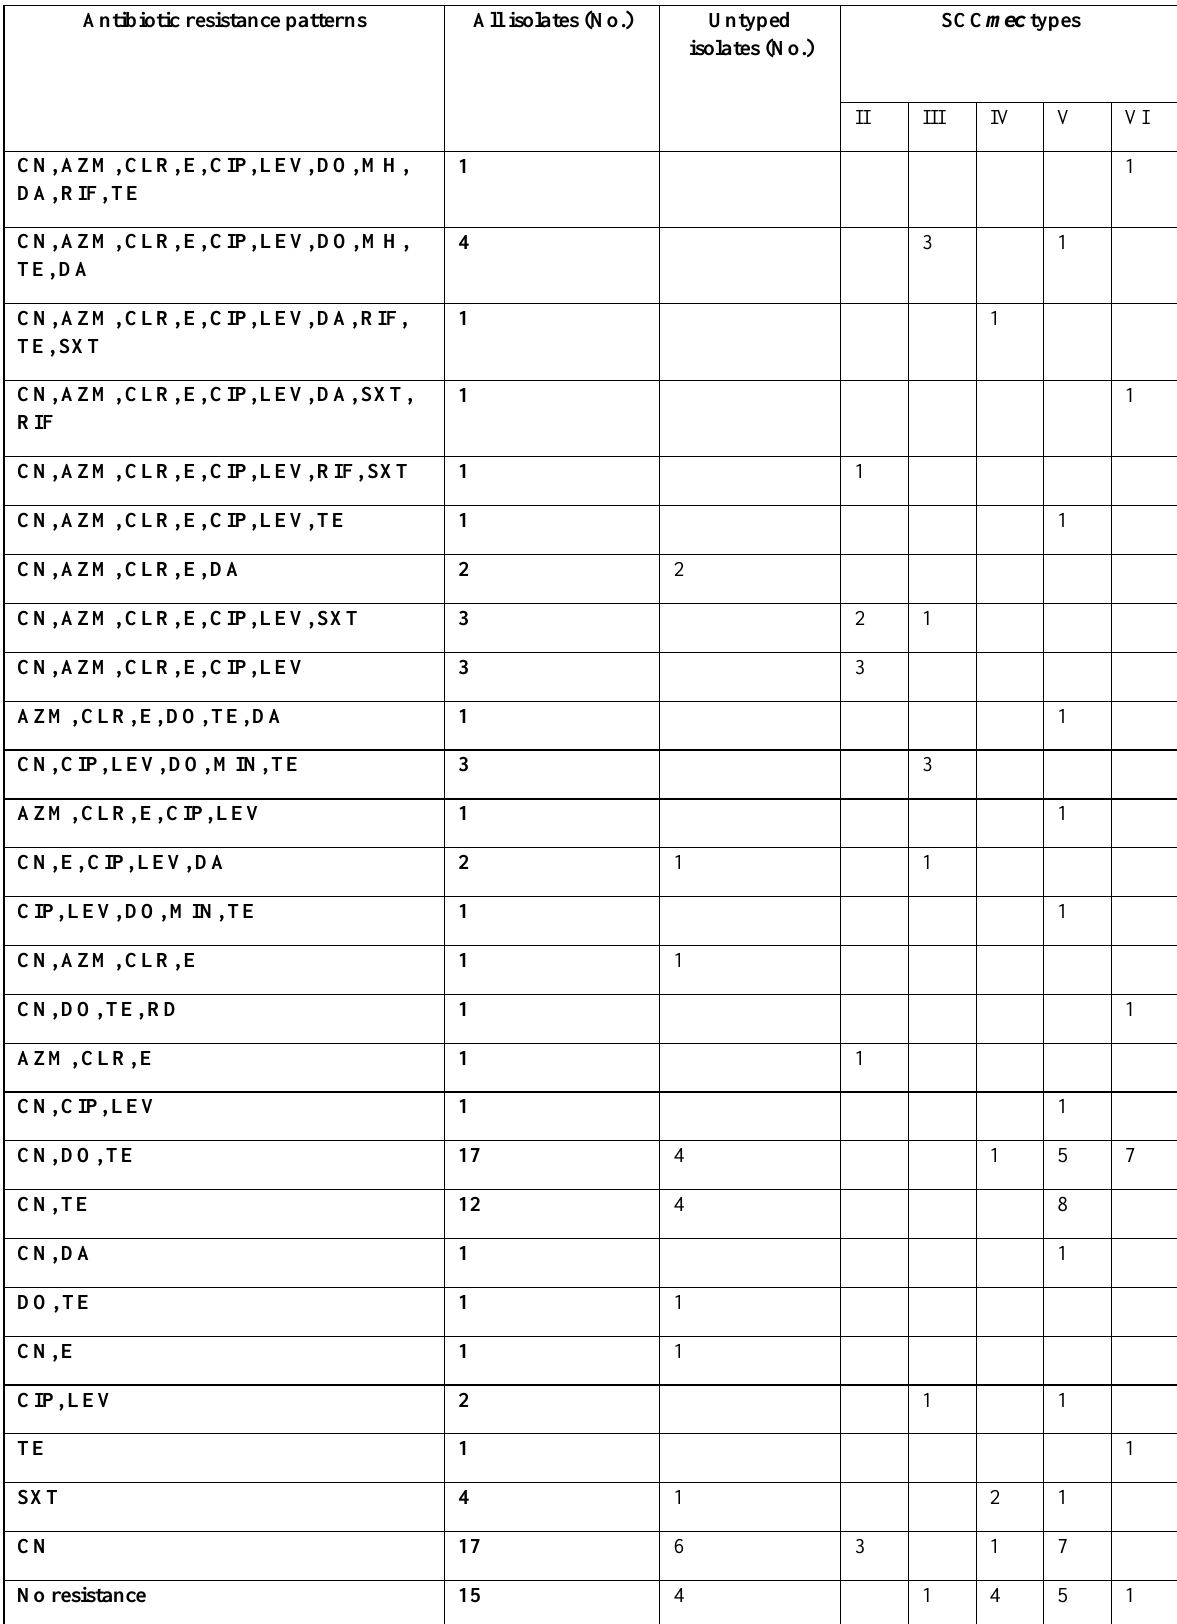
Table 3. Antibiotic resistance patterns and the corresponding SCC mec types. Antibiotic resistance patterns All isolates (No.) Untyped